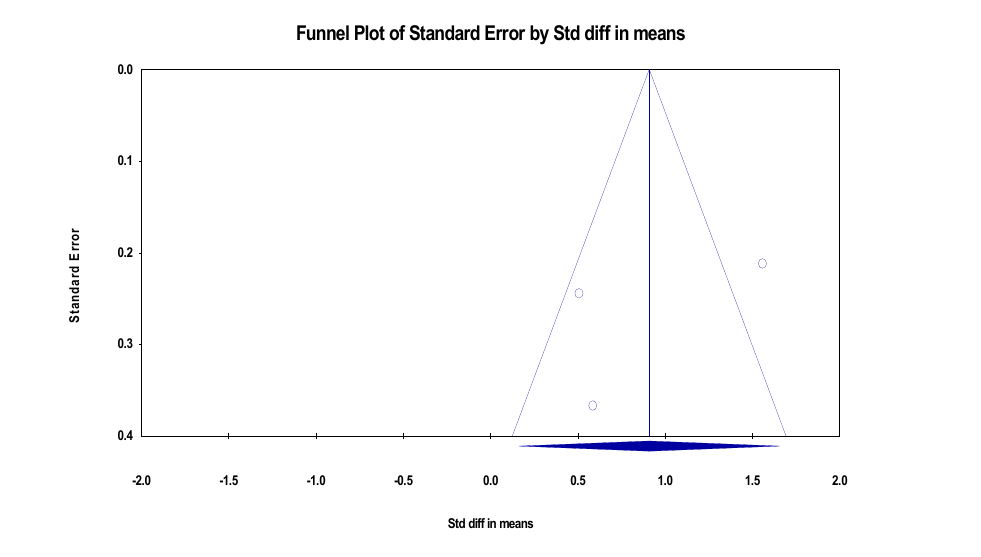
Figure 5. Funnel plot of suicidal ideation of MBCT on depression.